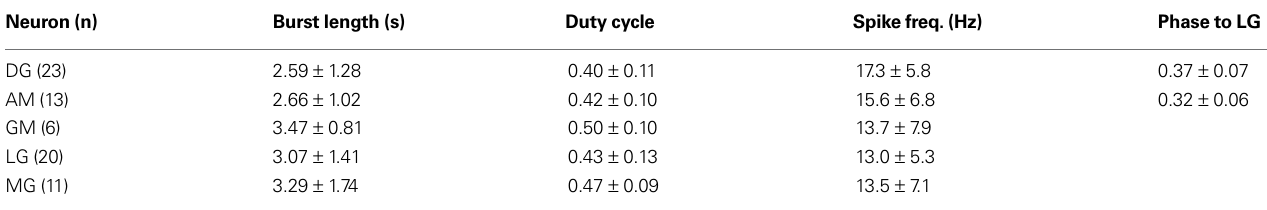
Table 2 | Gross temporal parameters of the burst patterns of fi ve types of gastric neurons (number of preparations indicated in brackets). Means and standard deviations are shown. Duty cycles show consistently less variability across preparations than the burst length or within-cycle spike frequency. Relative phases between the DG/LG and AM/LG neurons have even smaller